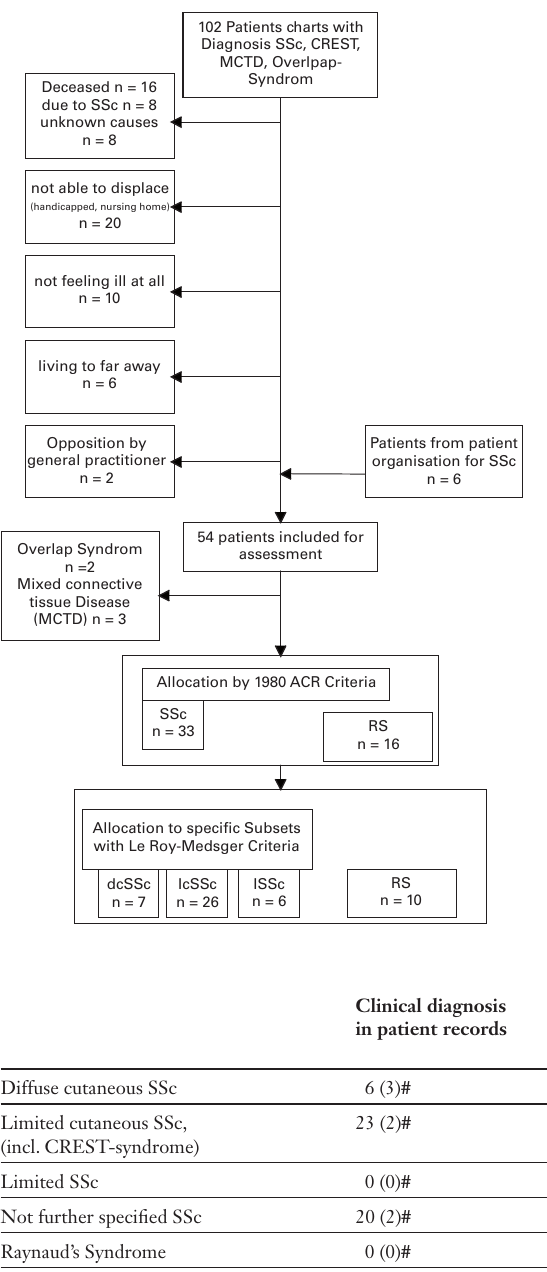
102 Patients charts with Diagnosis SSc, CREST,